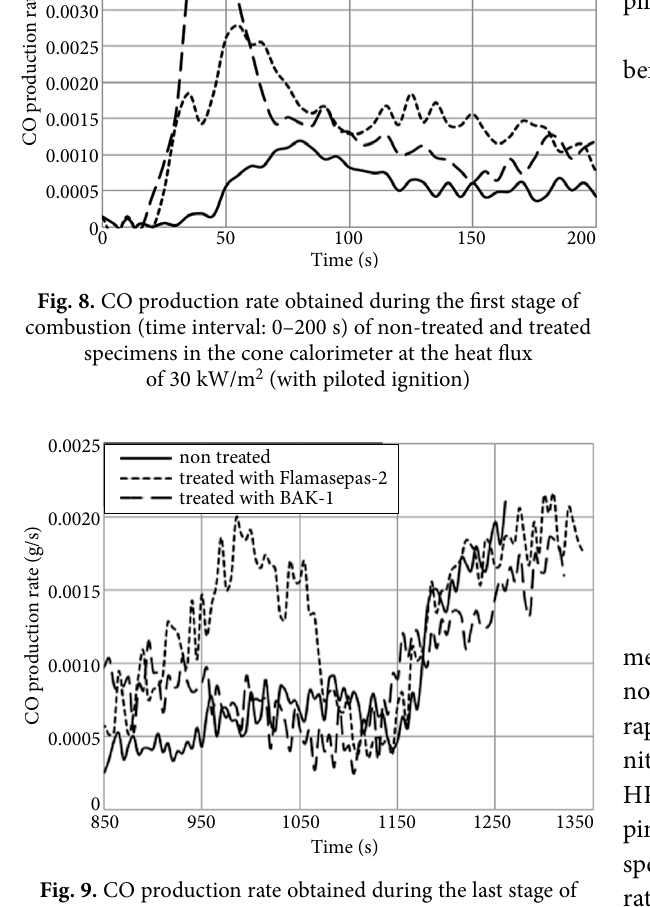
Fig. 9. CO production rate obtained during the last stage of combustion (time interval: 850–1350 s) of non-treated and treated specimens in the cone calorimeter at the heat flux of 30 kW/m 2 (with piloted ignition)